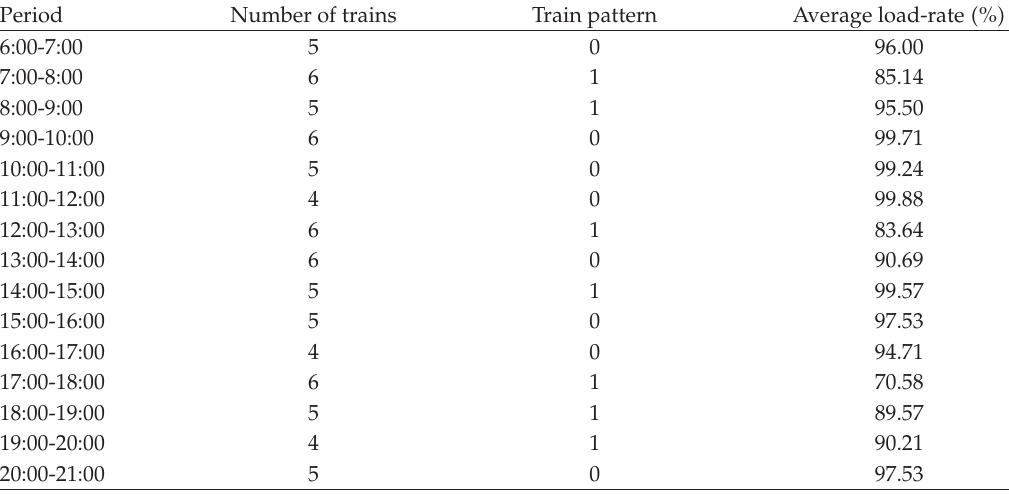
Table 2: The number of trains and train pattern during each